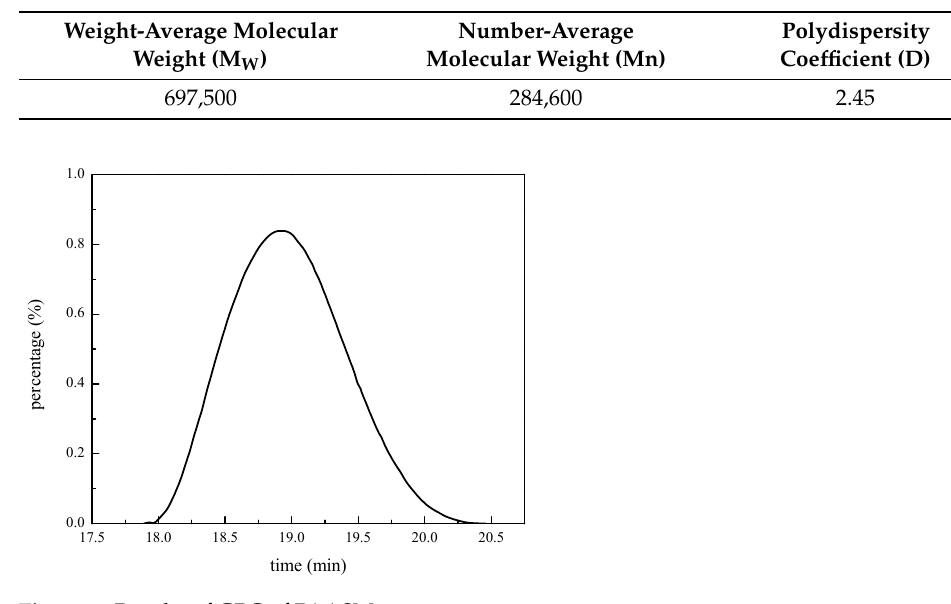
Figure 4. Results of GPC of PAASM.